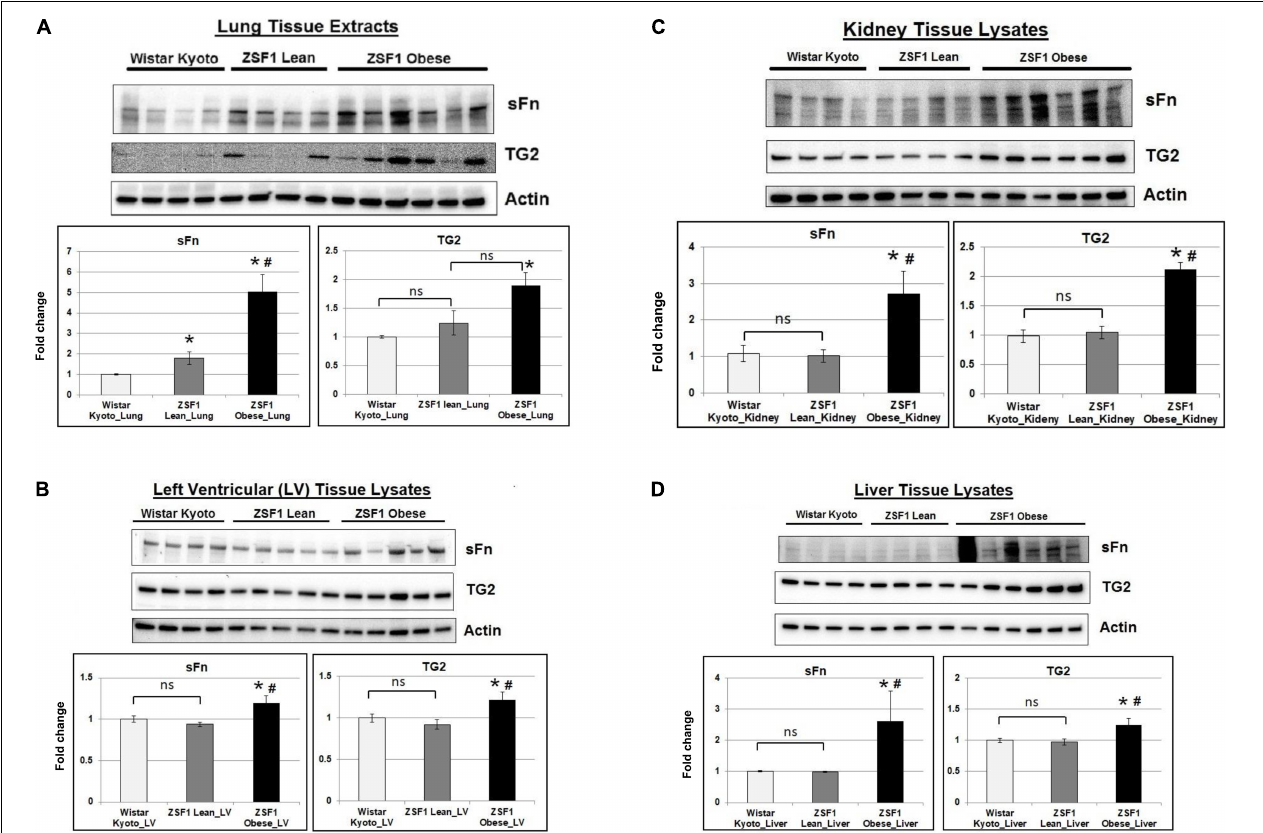
FIGURE 1 | TG2 activity and expression are increased in a rat model of metabolic syndrome. Representative Western blot images showing serotonylated fibronectin (sFn) and transglutaminase 2 (TG2) expression levels in (A) lung, (B) cardiac left ventricular, (C) kidney, and (D) liver tissues of Wistar Kyoto, ZSF1 lean and ZSF1 obese rats. Beta-actin was used as a loading control. Bar graphs showing the normalized fold change differences compared to Wistar Kyoto rats. Data are expressed as mean ± SEM. n ≥ 4 rats per group. * p < 0.05 compared to Wistar Kyoto rats. # p < 0.05 compared to ZSF1 lean rats by one-way ANOVA. ns = not